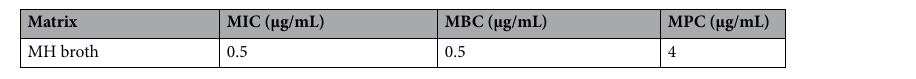
Table 3. MIC, MBC, and MPC (µg/mL) of DAN against E. coli HP501 (O 158 ).